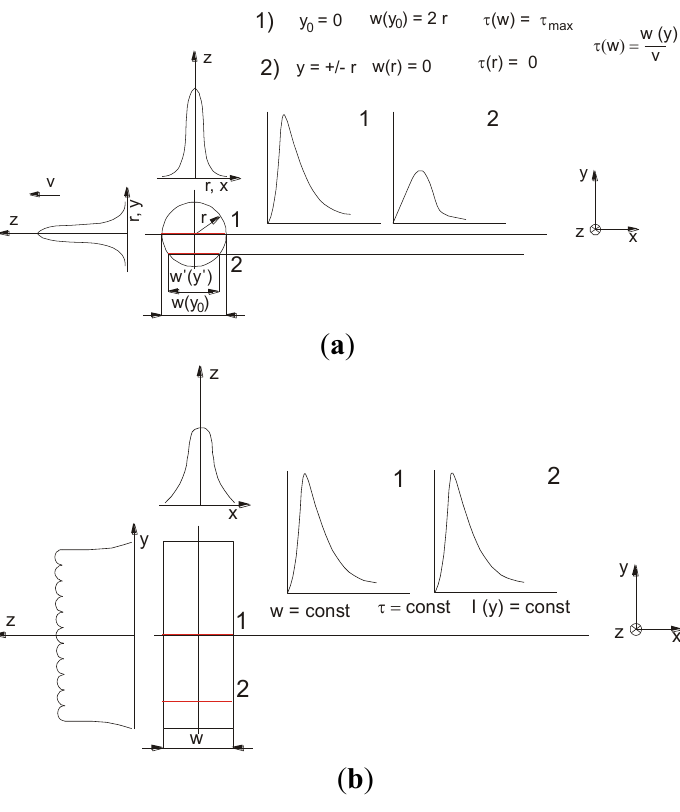
Figure 1. The differences in surface heating by ( a ) the circular laser beam with a Gaussian single mode of energy distribution (TEM 00 ) and ( b ) the rectangular laser beam with uniform energy distribution (Top-hat, multimode profile, shown also in Figure